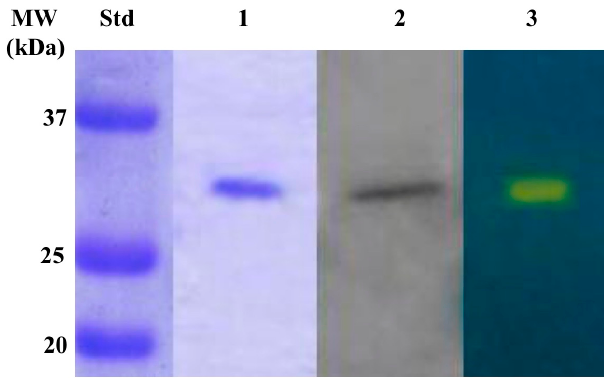
Figure 4. Combined results obtained with SDS-PAGE, Western blot and protonography, which were used to evaluate the recombinant CynT2 product purified by affinity column. The yellow band evidenced in the protonogram corresponds to the enzyme activity responsible for the drop of pH from 8.2 to the transition point of the dye in the control buffer. Lane STD, molecular markers (form bottom to the top: 20, 25, and 37 kDa); Lane 1, SDS-PAGE; Lane 2, Western Blot; Lane 3, Protonogram; Molecular markers (Lane STD).